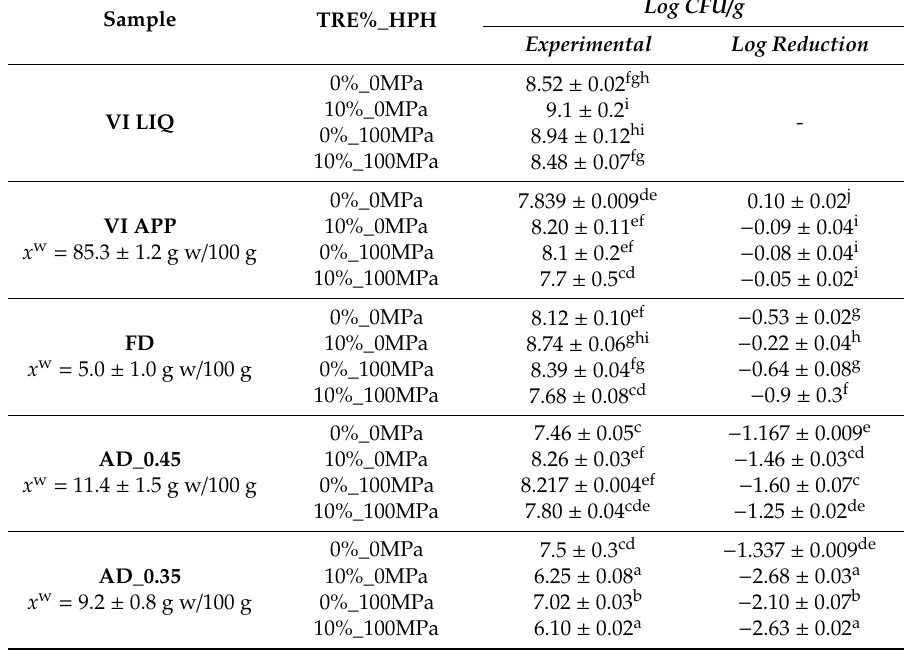
Table 1. Microbial counts in vacuum impregnating liquids (VI LIQ) and apple samples: comparison between predicted and experimental values. VI APP stands for vacuum impregnated apples, FD stands for freeze-dried apples, AD_0.45 stands for apples air-dried until reaching a water activity value a w ≈ 0.45 and AD_0.35 stands for apples air-dried until reaching a a w ≈ 0.35. Mean value of three replicates ± standard deviation. Di ff erent letters in the same column indicate statistically significant di ff erences with a 95% confidence level ( p -value <